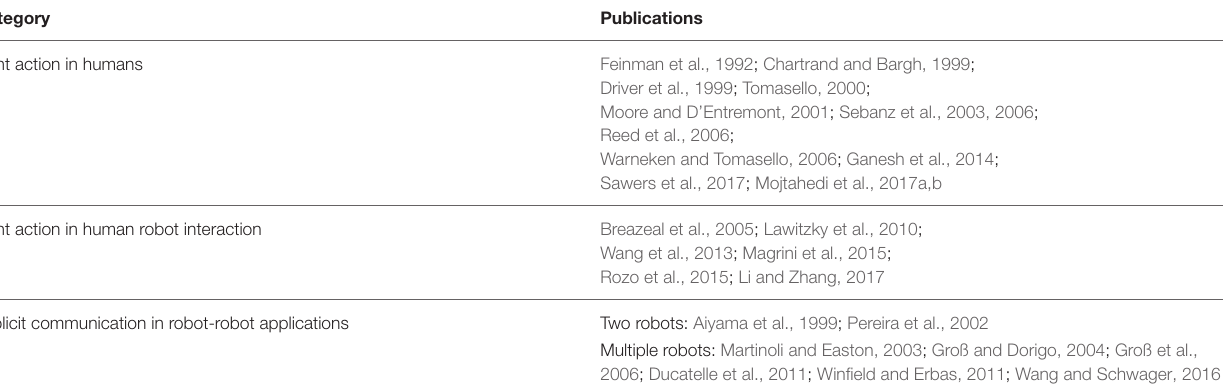
TABLE 1 | An overview of existing literature that may underpin future research on joint action in cooperative object manipulation for shared autonomy